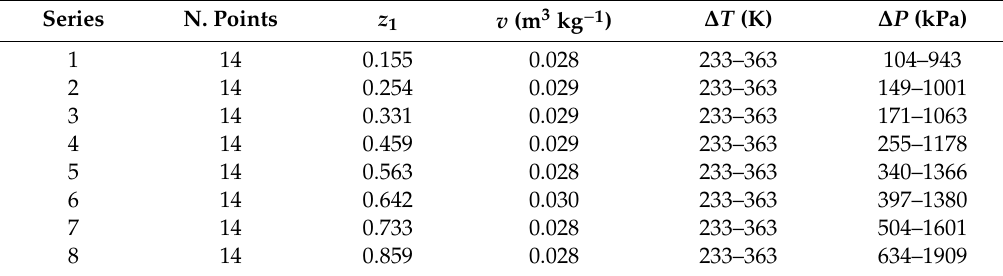
Table 3. Measurements at bulk compositions z 1 and average specific volumes v for R744 (1) + R1234ze(E) (2) binary system over the temperature range ∆ T and pressure range ∆ P .